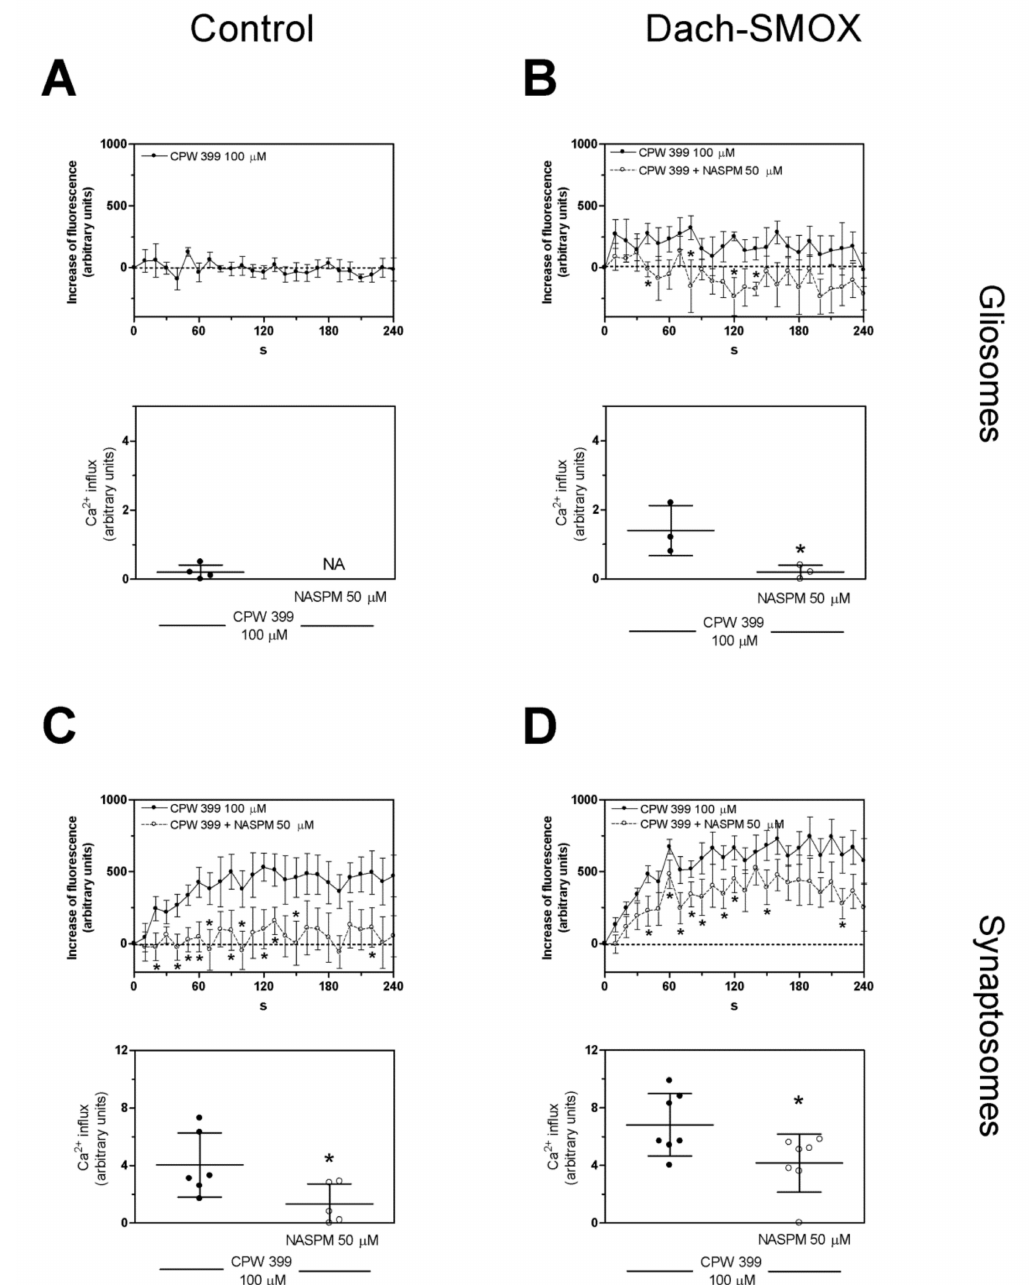
Figure 4. Antagonism by NASPM of the [Ca 2+ ] i influx evoked by AMPA receptor activation in Dach-SMOX cerebrocortical gliosomes and synaptosomes. CG-loaded particles (gliosomes or synaptosomes) were treated with 100 µ M CPW399 in the absence ( • ) or in the presence ( ) of the selective antagonist of GluA2-lacking AMPA receptor NASPM (50 µ M) for the (cid:35) indicated time at 37 ◦ C. CG-dependent fluorescence was monitored every 10 s from 0 to 240 s. [Ca 2+ ] i increase is expressed as “increase of fluorescence”. The areas reported in each upper panel were quantified to estimate the calcium influxes. ( A ) [Ca 2+ ] i increase (upper panel) and calcium influx (lower panel) in gliosomes from control mice. Data are means ± SEM from four ( • ) independent experiments in triplicate. NA, not assessed. ( B ) [Ca 2+ ] i increase (upper panel) and calcium influx (lower panel) in gliosomes from Dach-SMOX mice. Data are means ± SEM from three ( • , ) independent experiments in (cid:35) triplicate. ( C ) [Ca 2+ ] i increase (upper panel) and calcium influx (lower panel) in synaptosomes from control mice. Data are means ± SEM from six ( • ) or five ( ) independent experiments in triplicate. ( D ) [Ca 2+ ] i increase (upper panel) and calcium (cid:35) influx (lower panel) in synaptosomes from Dach-SMOX mice. Data are means ± SEM from seven ( • , ) independent (cid:35) experiments in triplicate. * p ≤ 0.05, according to Mann–Whitney